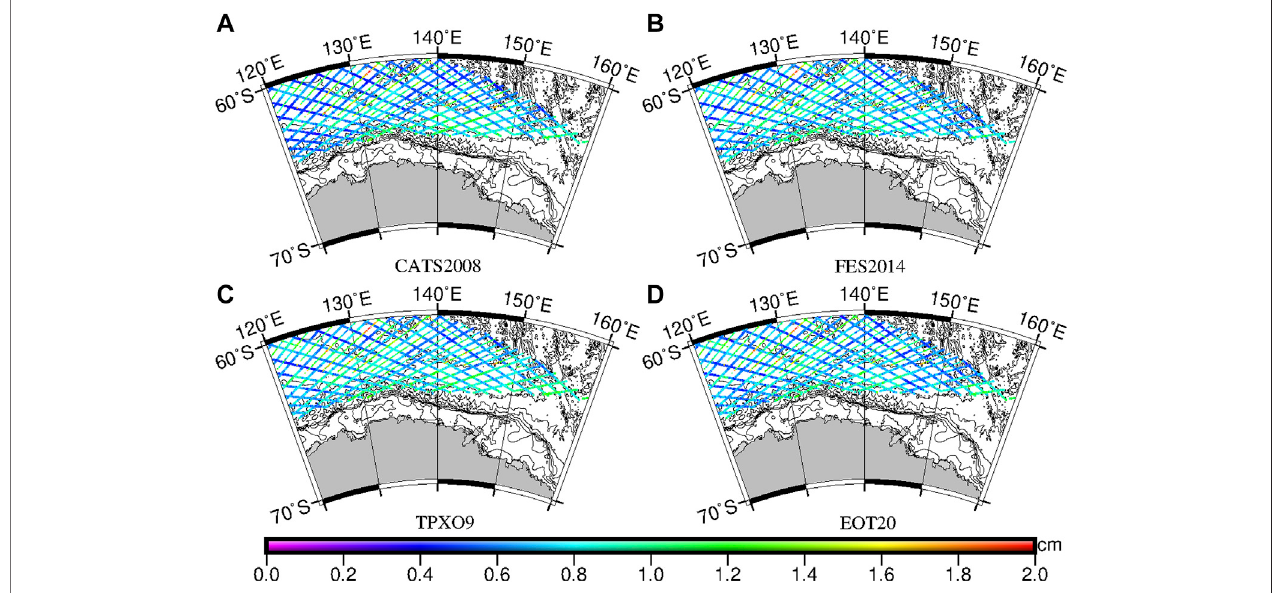
FIGURE 12 | RSS of each along-track point of (A) CATS2008, (B) FES2014, (C) TPXO9, and (D) EOT20 in the Adelie-Mertz, including original orbit (large points) and interleaved orbit (small points).